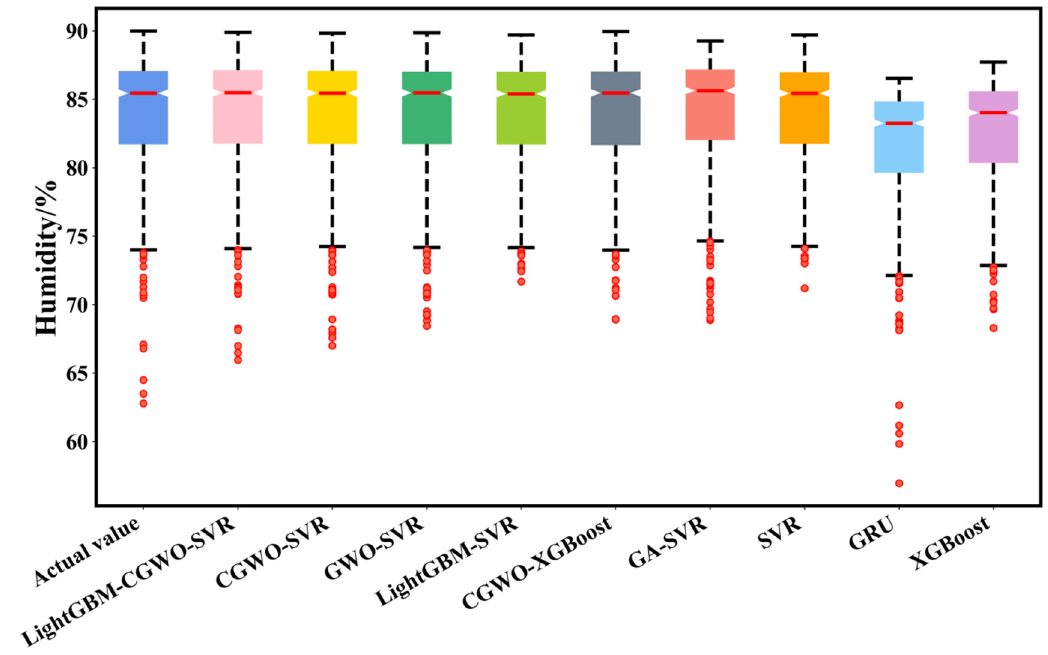
Figure 8. Box schemes of actual versus computed humidity (validation level).